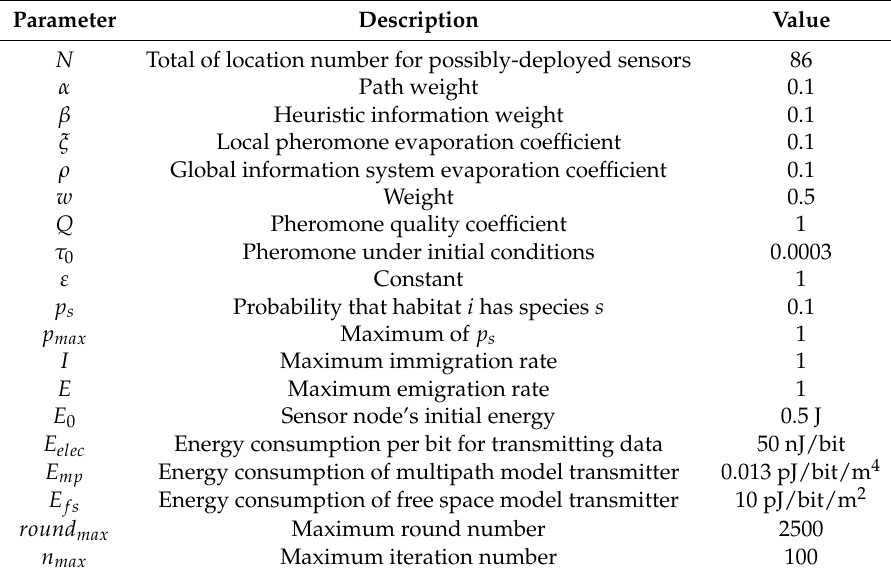
Table 1. Parameter